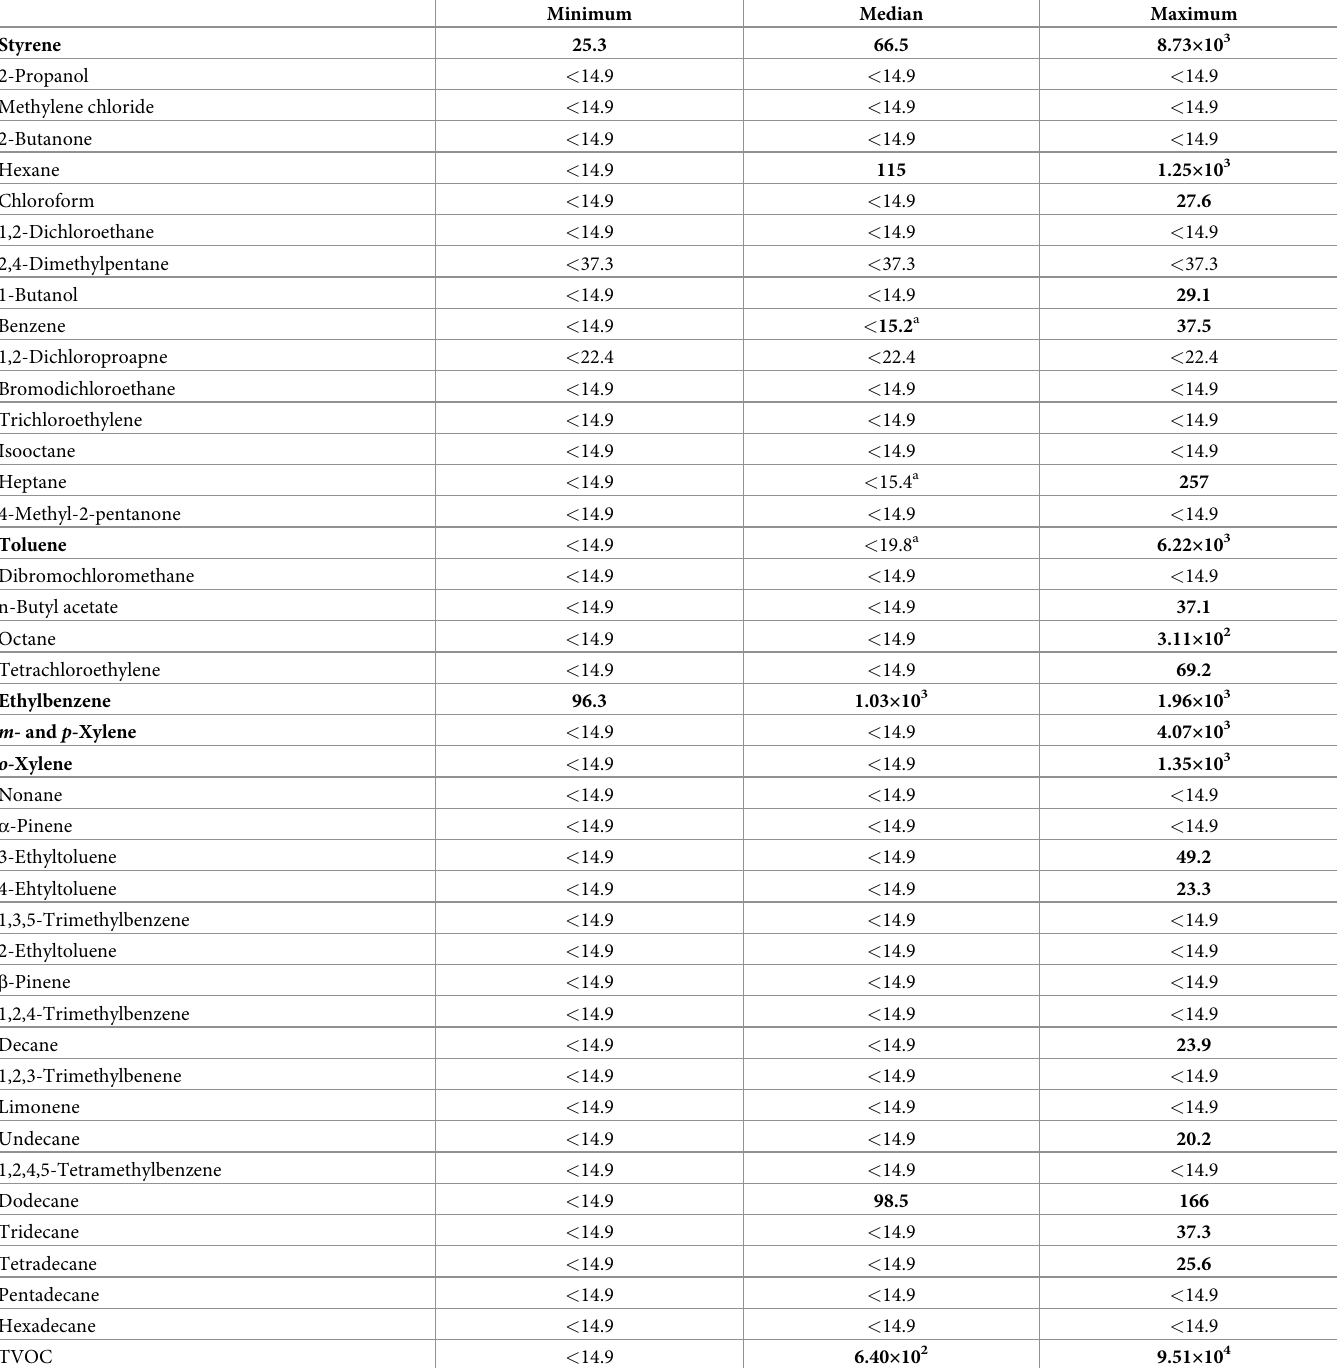
Table 2. Emission fluxes ( μ g/(m 2 h) for styrene, 42 other volatile organic compounds, and Total Volatile Organic Compounds (TVOC) for the samples ( n = 12) at